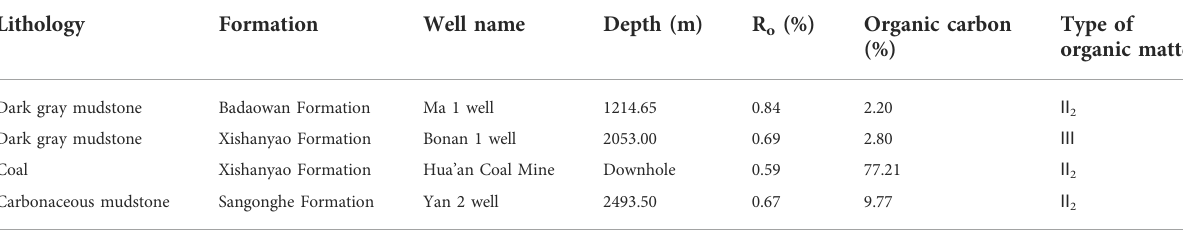
TABLE 1 Basic information on the samples from the Jurassic in the Yanqi